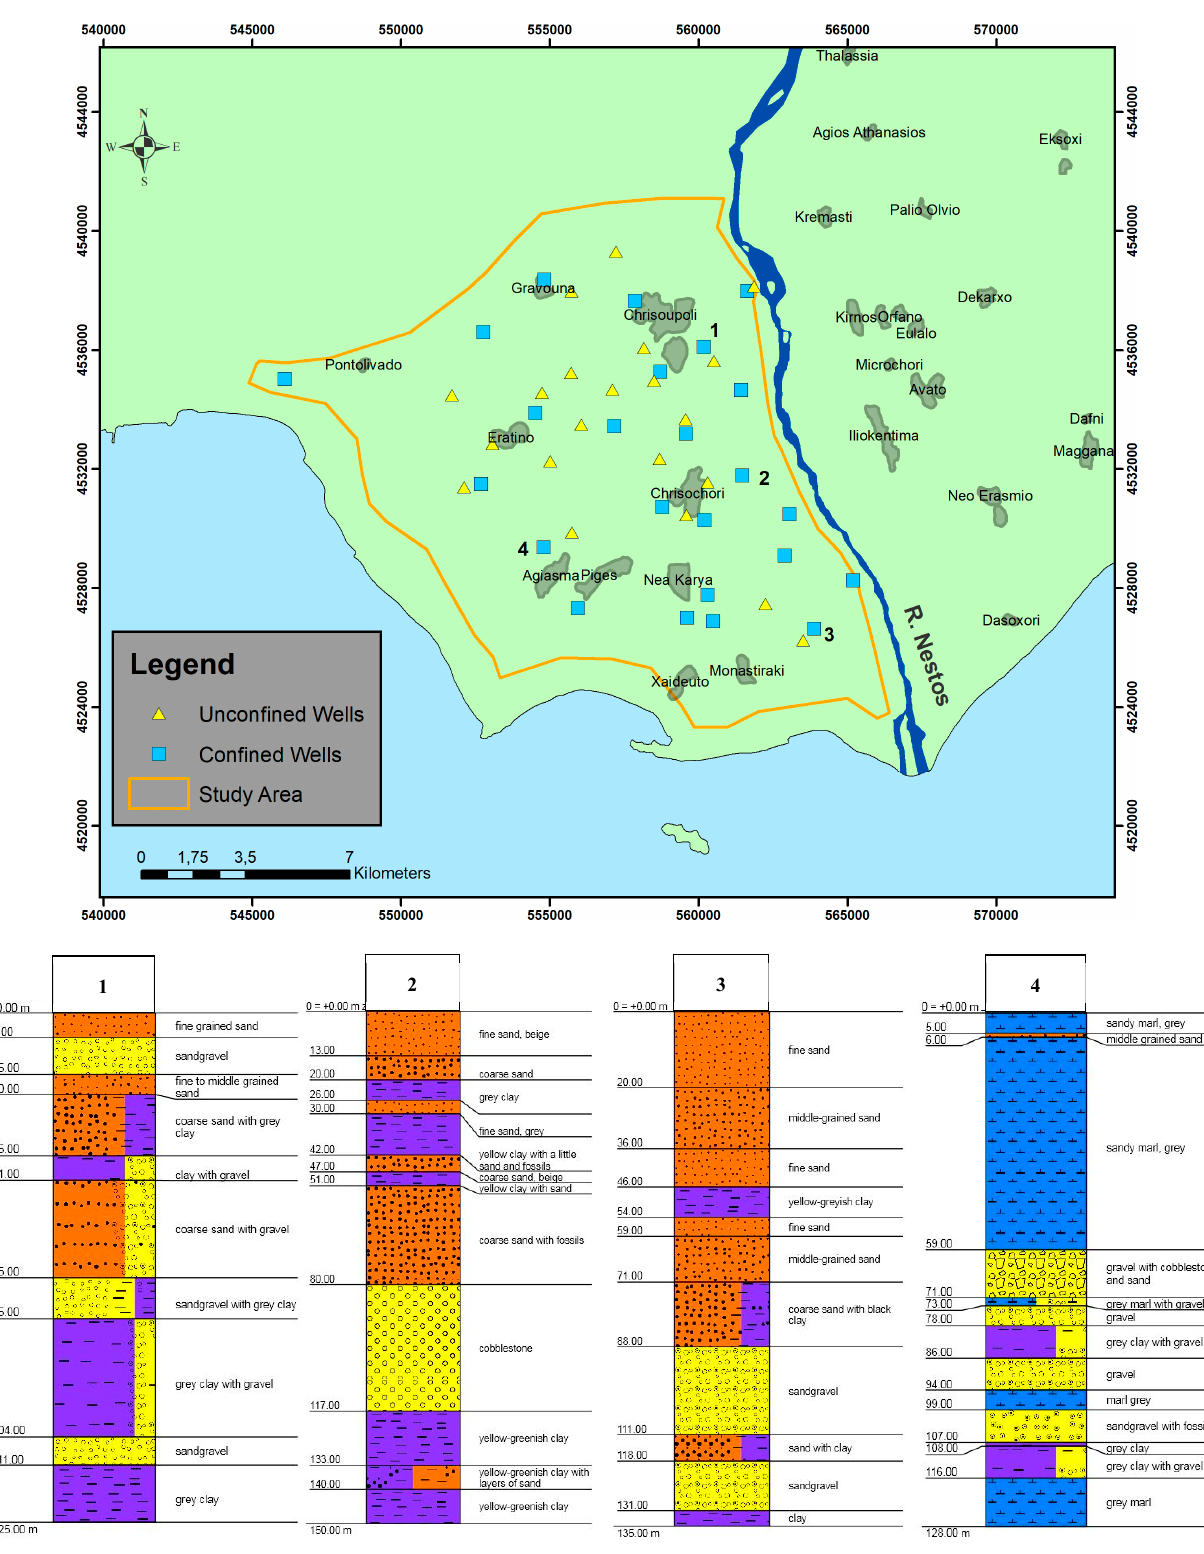
Figure 4. Upper: groundwater monitoring network points. Lower: geological sections of confined wells 1, 2, 3, 4, the positions of which are shown in the upper map.